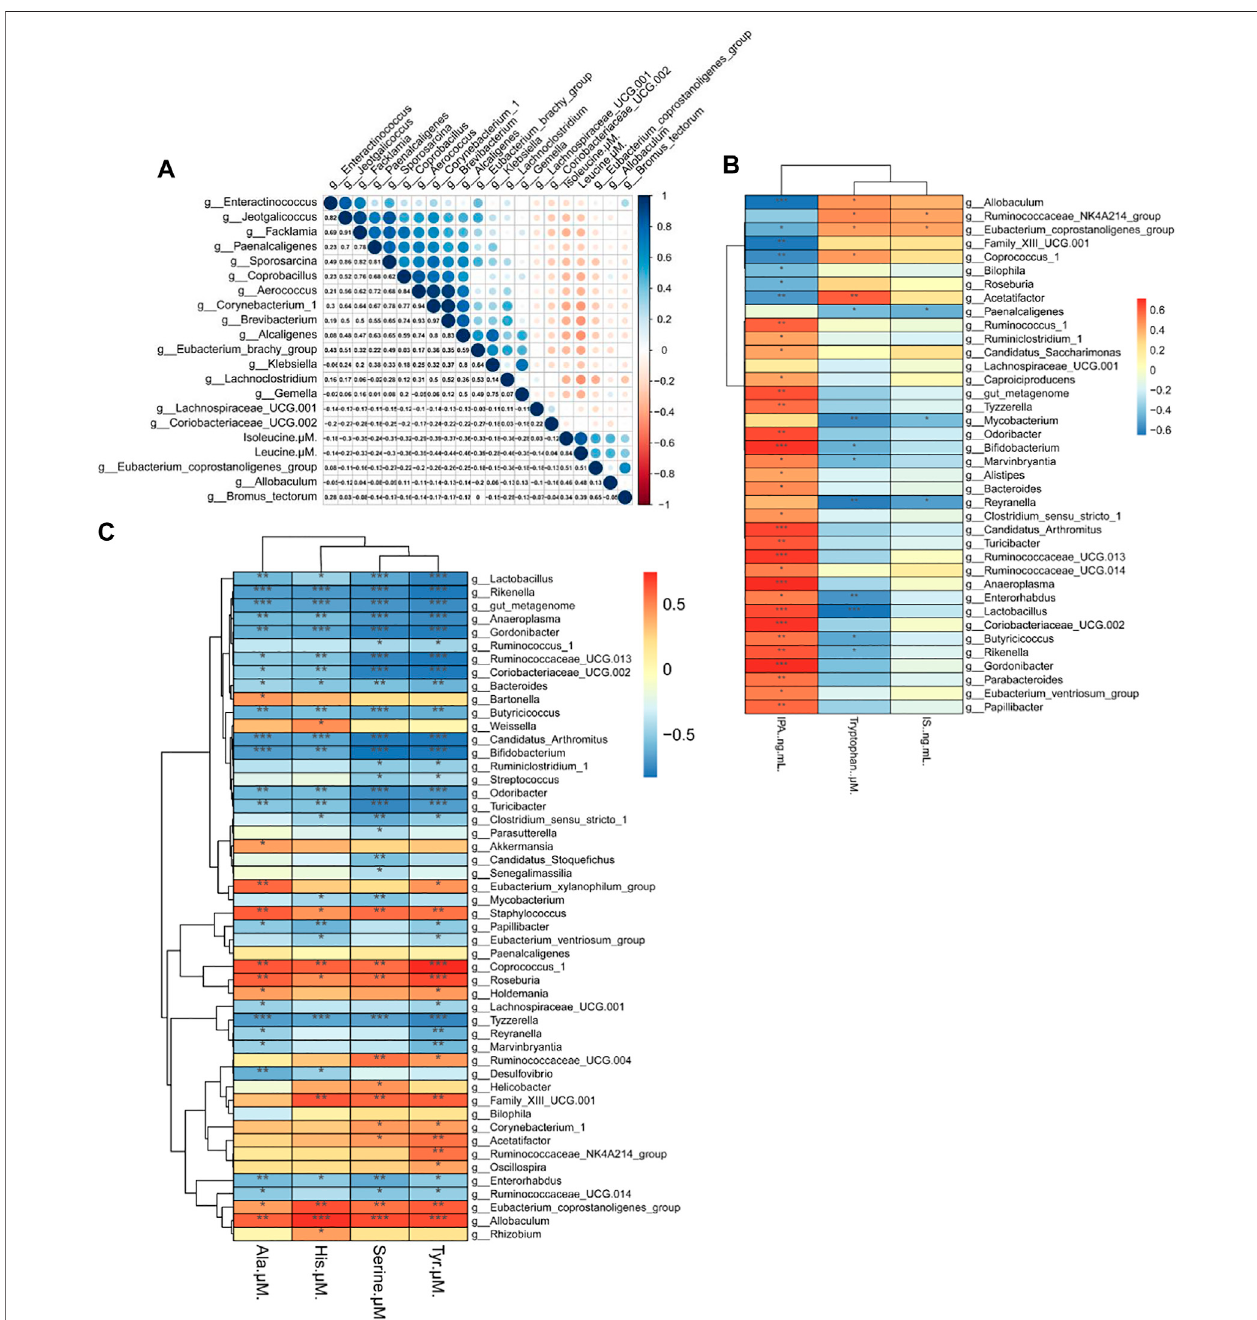
FIGURE 7 | Heat map of the correlation between the gut microbiota and biochemical indexes in mice. (A) Correlation between the gut microbiota and Iso (isoleucine), Leu (leucine). (B) Correlation of the gut microbiota with Trp (tryptophan), IPA (indolepropionic acid) and IS (indoxyl sulfate) (C) Correlation between the gut microbiota and His (histidine), Ala (alanine), Ser (serine), and Tyr (tyrosine). Spearman ’ s rank test. Signi fi cance among different correlation coef fi cients described as * p < 0.05, ** p < 0.01, and ** p < 0.001.